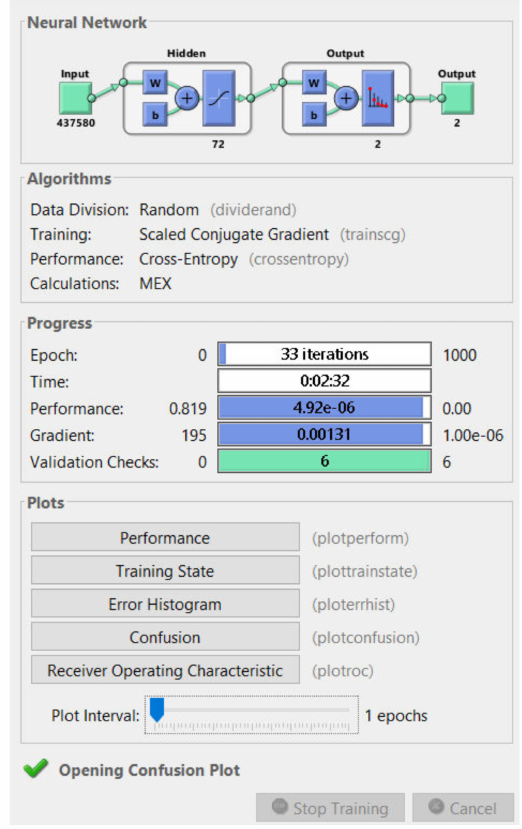
Figure 9. Neural network training